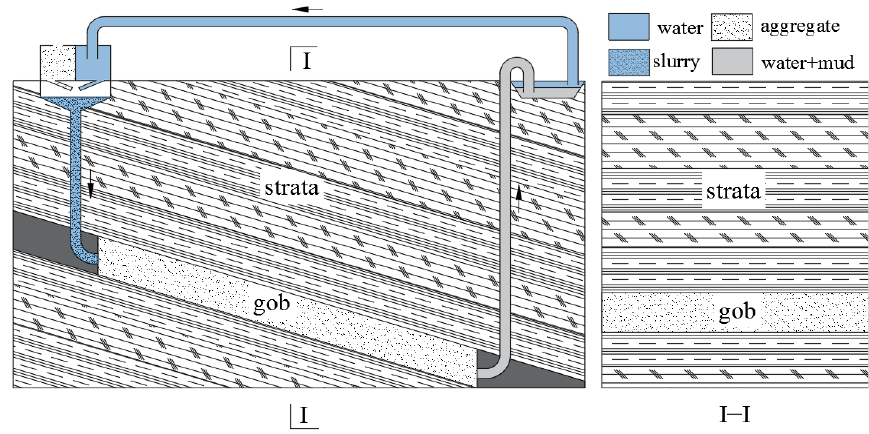
Figure 4. Hydraulic backfill mining system.